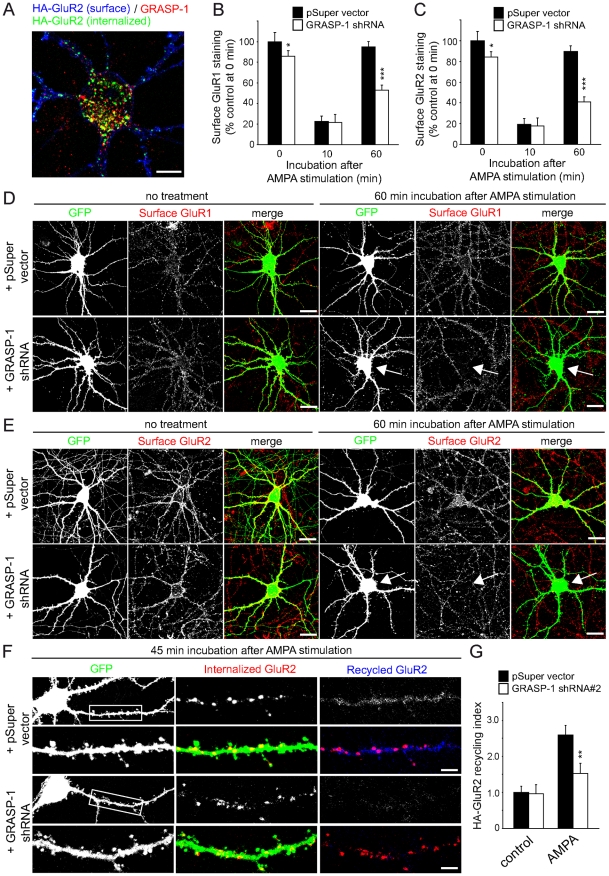
Knock-down of GRASP-1 reduces AMPAR recycling.(A) Representative merge image of surface HA-GluR2 (blue) and internalized HA-GluR2 (green) in soma and dendrites of hippocampal neurons labeled for GRASP-1 (red) after 10 min AMPA stimulation. Bar is 10 µm. (B,C) Quantification of the surface fluorescence intensities of endogenous GluR1 (B) and GluR2 (C) in control pSuper vector or GRASP-1-shRNA#2 transfected neurons. The cells were untreated (0 min) or stimulated with AMPA for indicated times. Histograms show fluorescent intensity of surface GluR subunit staining relative to the intensity of GFP transfected control neurons at basal levels. n = 20 cells for each group. (D,E) Representative images of hippocampal neurons stained for endogenous surface GluR1 (D) and GluR2 (E). Hippocampal neurons at DIV13 were cotransfected with GFP and pSuper control vector or GRASP-1-shRNA#2. At DIV17, neurons were fixed (0 min, no treatment) or stimulated for 2 min with 100 µM AMPA in the presence of 50 µM APV and further incubated for a total of 10 or 60 min before fixation. Endogenous surface GluR1 (D) or GluR2 (E) was revealed by immunofluorescence labeling without permeabilization using specific extracellular AMPAR antibodies. Bar is 20 µm. (F) Neurons transfected with GFP, HA-GluR2, and either pSuper control vector or GRASP-1-shRNA#2 were stained live with an anti-HA antibody, stimulated for 2 min with AMPA/APV, acid stripped, and incubated in conditioned media for 45 min. Recycled HA-GluR2 (blue) and internalized HA-GluR2 (red) were sequentially labeled. Bar is 1 µm. (G) Quantification of the ratio of recycled to internalized HA-GluR2 and normalized to unstimulated wild-type control neurons (HA-GluR2 recycling index) as indicated in (F). Error bars indicate S.E.M. * p<0.05. ** p<0.005. *** p<0.0005.